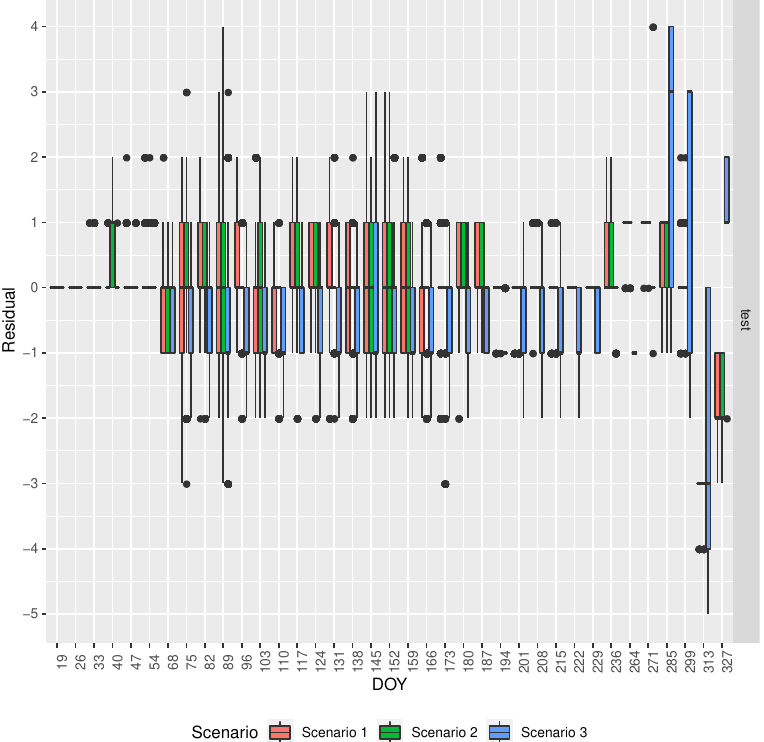
Figure 11. Comparison of the residuals by DOY for the different models’ in the scenarios described in Table